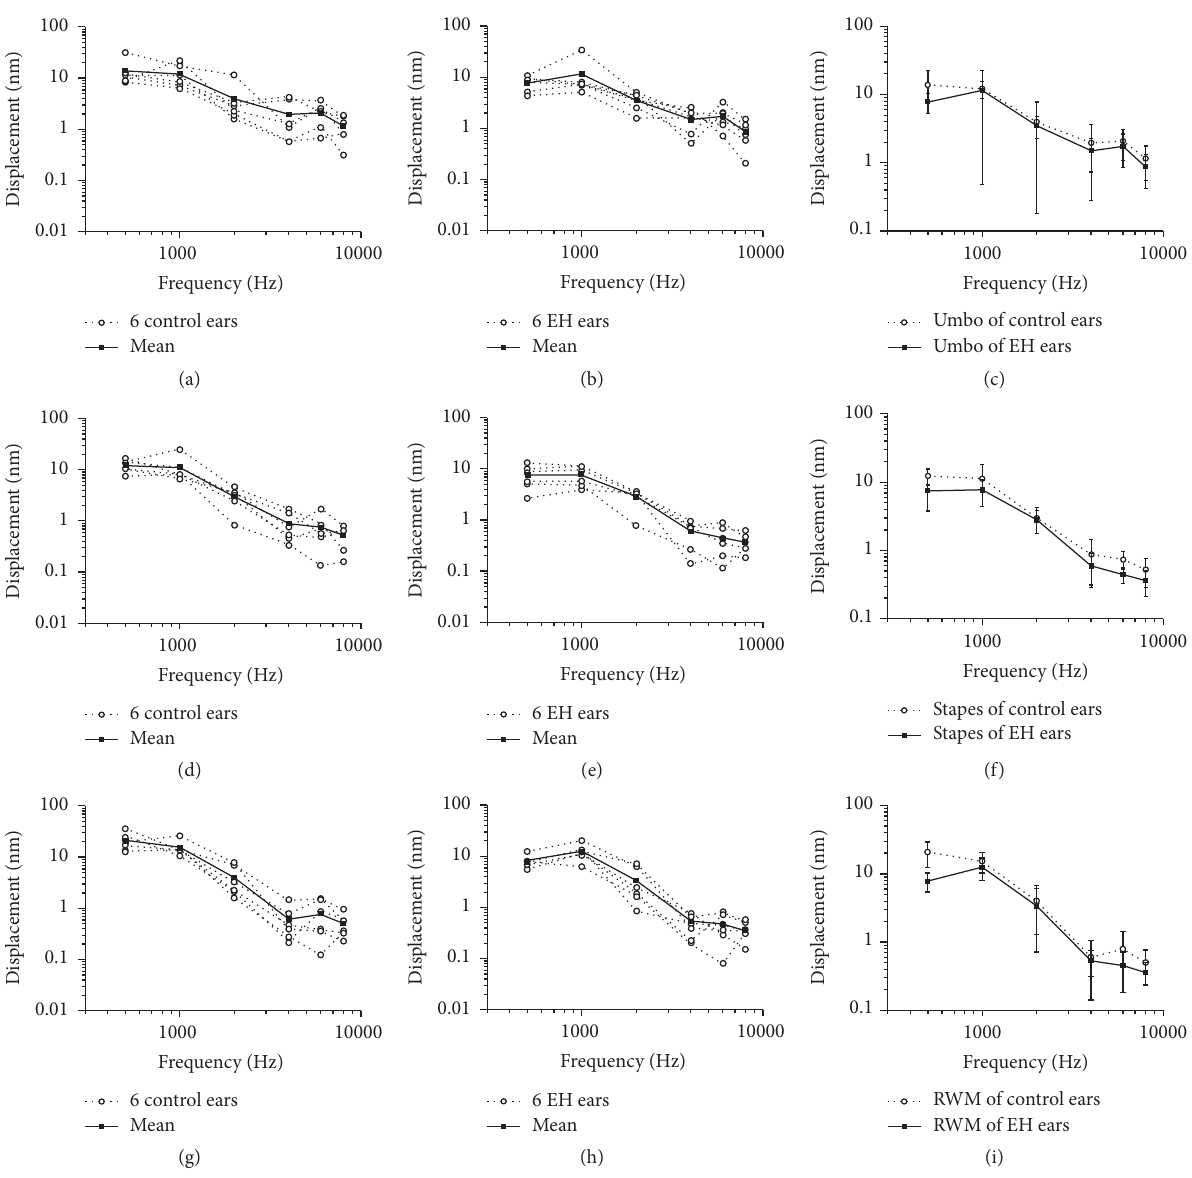
Figure 5: Peak-to-peak displacement-frequency curve of the umbo (a–c), stapes head (d–f), and round window membrane (RWM) (g–i) in response to 85dB SPL sound stimuli at the ear canal. (a) Six individuals and their mean value in the control group (dotted line for the individuals and solid line for the mean value). (b) Six individuals and their mean value in the endolymphatic hydrops (EH) group (dotted line for the individuals and solid line for the mean value). (c) Mean ± SD ( 𝑛 = 6 ) of the control and EH groups, respectively: dotted line for the control group and solid line for the EH group. (d) Six individuals and their mean value in the control group (dotted line for the individuals and solid line for the mean value). (e) Six individuals and their mean value in the endolymphatic hydrops (EH) group (dotted line for the individuals and solid line for the mean value). (f) Mean ± SD ( 𝑛 = 6 ) of the control and EH groups (dotted line for the control group and solid line for the EH group). (g) Six individuals and their mean value in the control group (dotted line for the individuals and solid line for the mean value). (h) Six individuals and their mean value in the endolymphatic hydrops (EH) group (dotted line for the individuals and solid line for the mean value). (i) Mean ± SD ( 𝑛 = 6 ) of the control and EH groups (dotted line for the control group and solid line for the EH